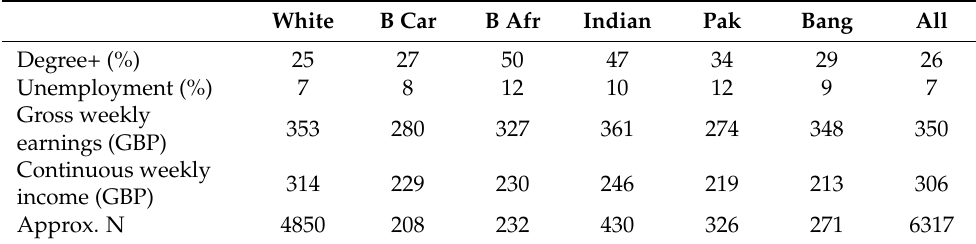
Table 1. Selected characteristics of educational attainment and labour market position at age 25. White B Car B Afr Indian Pak Bang All 25 27 50 47 34 29 26 7 8 12 10 12 9 7 348 219 213